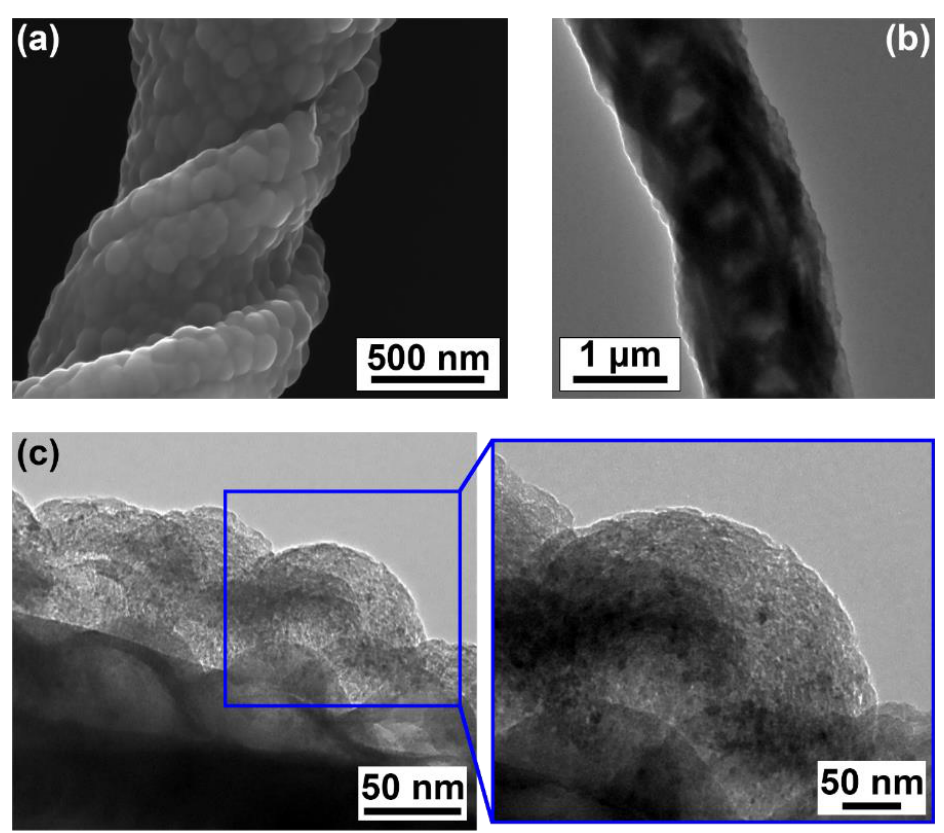
Figure 6. ( a ) SEM image of the surface of a G-NS. ( b ) TEM image of a single G-NS showing the GUITAR coating and the inner core of a NS. ( c ) TEM images of a single G-NS showing the interface of the NS and the GUITAR coating, and outset showing a side view of a single carbon nanosphere within the GUITAR coating.